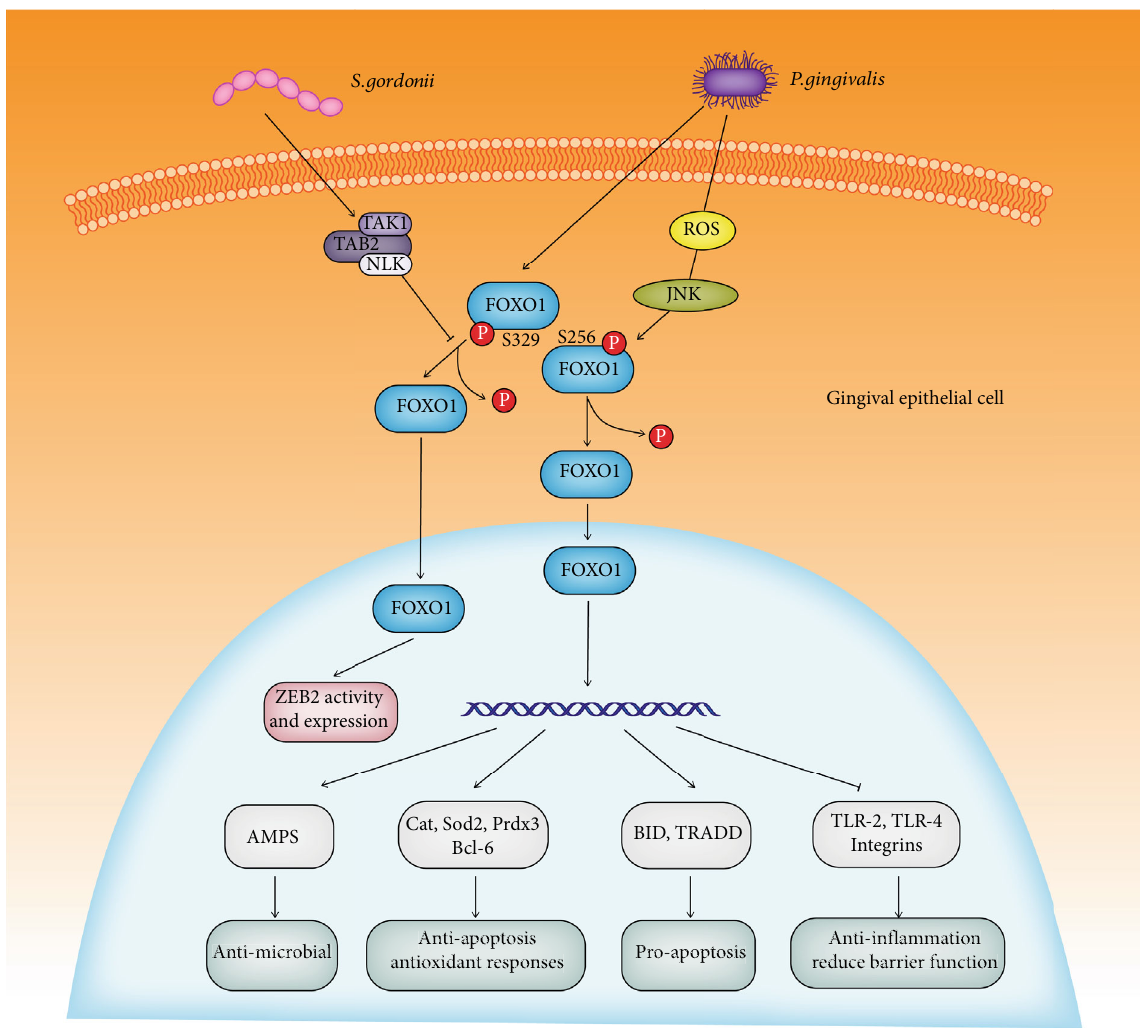
Figure 2: Regulation of FOXO1 activity by periodontal microbiota in gingival epithelial cells. FOXO1 (S256) can be dephosphorylated by P. gingivalis via ROS-JNK, promoting the nuclear localization of FOXO1. In the nucleus, FOXO1 mediates gene expression related to antimicrobial, antiapoptosis (Bcl-6), antioxidant response (Cat, Sod2, and Prdx3), proapoptosis (BID, TRADD), anti-in fl ammation (TLR- 2 and TLR4), and epithelial barrier function. FOXO1 (S329) can also be dephosphorylated during P. gingivalis infection, resulting in the activation of ZEB2, and this process can be inhibited by the negative role of TAK1-NLK pathway, which is activated by S. gordonii